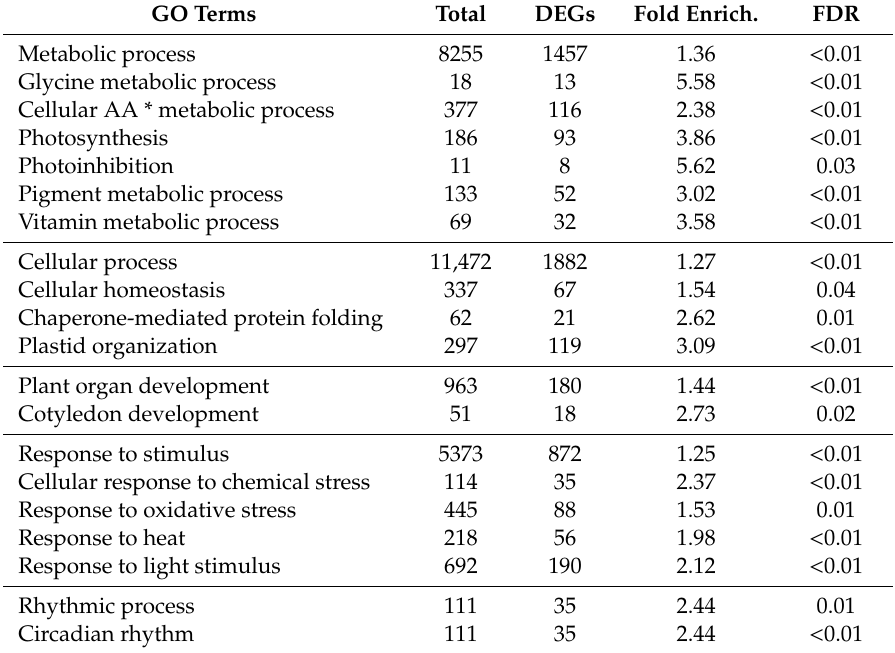
Table 2. Selected GO terms (biological process) for downregulated genes in the i-amiCHLI transgenic line after Dex treatment. GO Terms Total DEGs Fold Enrich.